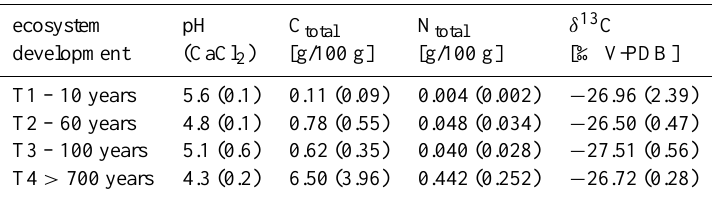
Table 1. Total C and N contents, pH-values and δ 13 C natural abundance in soil samples of the control treatments without litter application (means of n = 5 ± standard deviation) at different locations